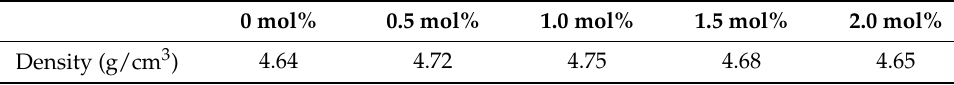
Table 1. Densities of NKLNTS-ST- x CuO